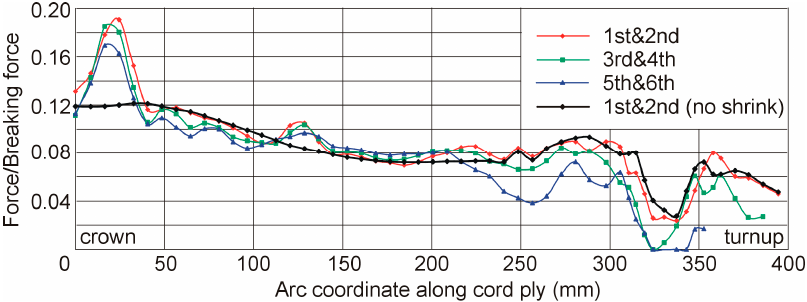
Figure 6. Cord tensile forces in all body plies and in two inner body plies with shrinkage neglected.